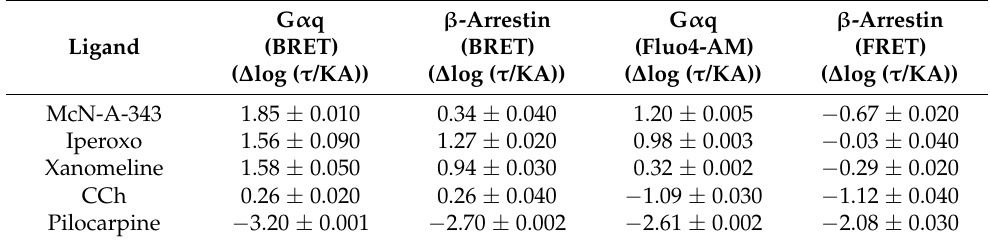
Table 1. The relative intrinsic activity of agonists towards signaling